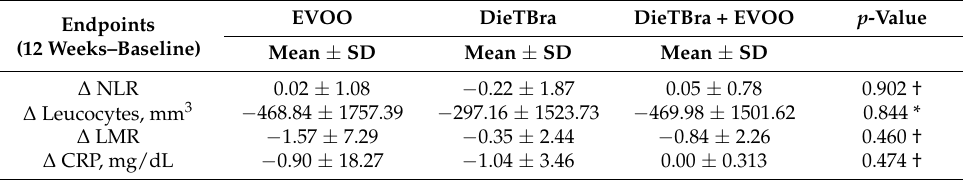
Table 4. Comparison of the delta values at baseline and after the 12-week follow